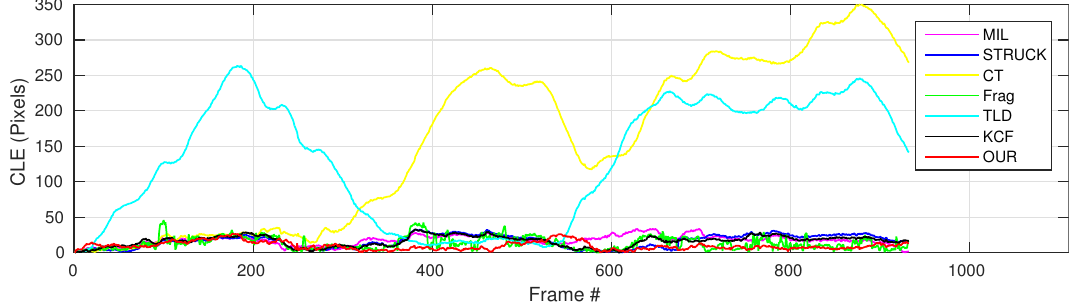
Figure 10. CLE error evolution plot of all trackers with the People bw image sequence.